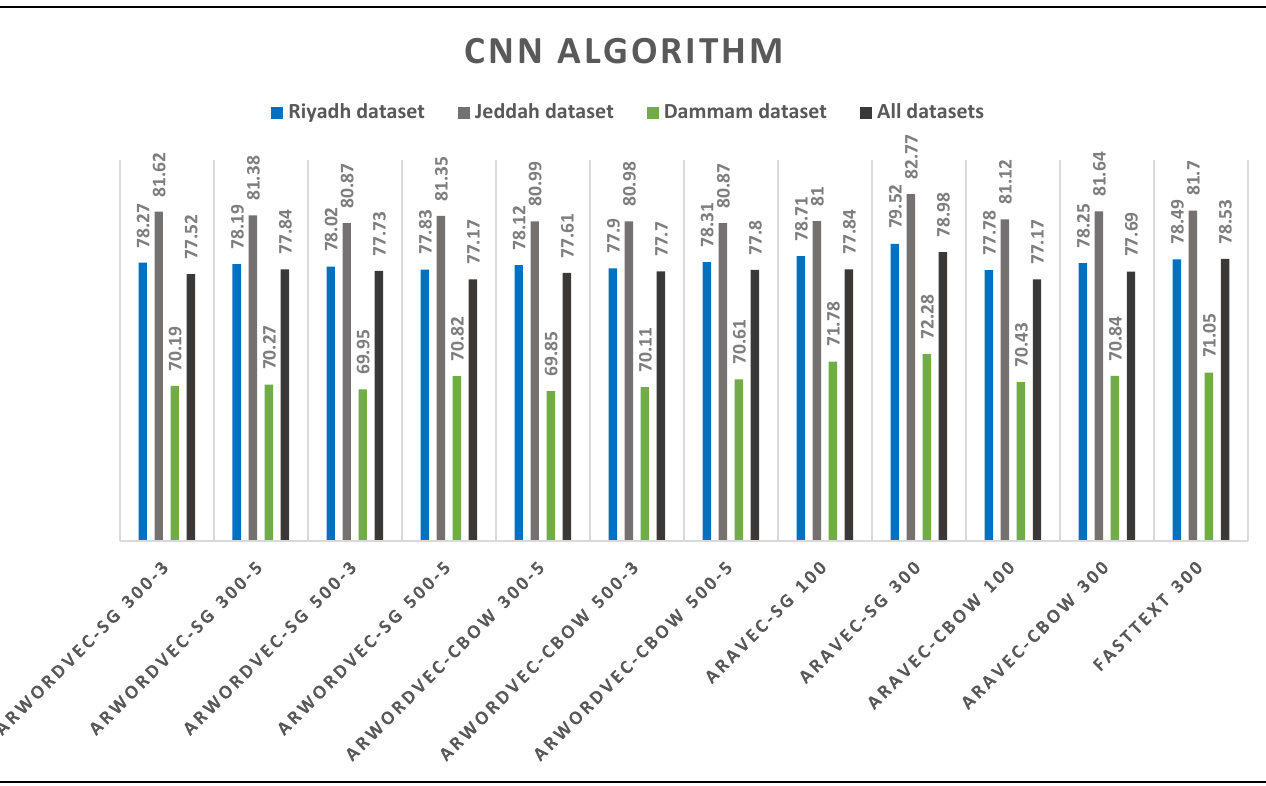
Figure 9. The Accuracies metric of CNN algorithm for comparing different Arabic pre-trained word embedding techniques for dataset during a COVID-19 pandemic.